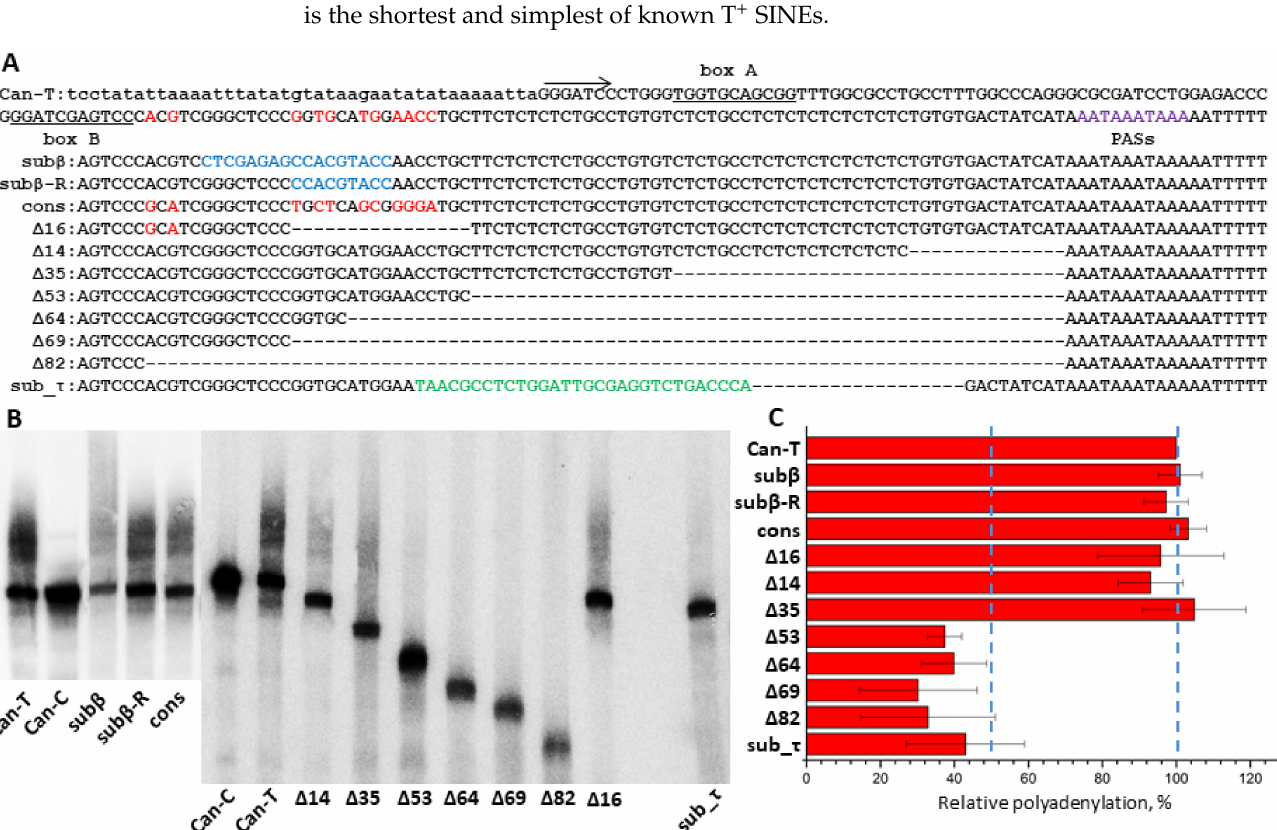
Figure 10. Identification of Can SINE regions required for polyadenylation of its pol III transcripts. ( A ) The Can sequence used in experiments (Can-T, above); the arrow indicates the transcription start; boxes A and B are underlined; polyadenylation signals (PASs) are shown in violet. Below is the alignment of the 3 (cid:48) -part of this sequence and derived constructs with modifications. The nucleotides different from the consensus in the region between the box B and TC-motif are given in red; blue marks the modifications in this region relative to the sequence above; modifications in the polypyrimidine region are shown in green. Deleted nucleotides, “-”. ( B ) Northern blot hybridization of RNA from HeLa cells transfected by Can constructs. The band and the smear above correspond to the primary and polyadenylated transcripts, respectively. Can-C is the construct with T-to-C substitutions in both polyadenylation signals, and its transcripts are not polyadenylated (For original image of Figure 10B, please refer to Supplementary Figure S11). ( C ) Polyadenylation efficiency of the modified constructs relative to Can-T. Error bars, SD, n =